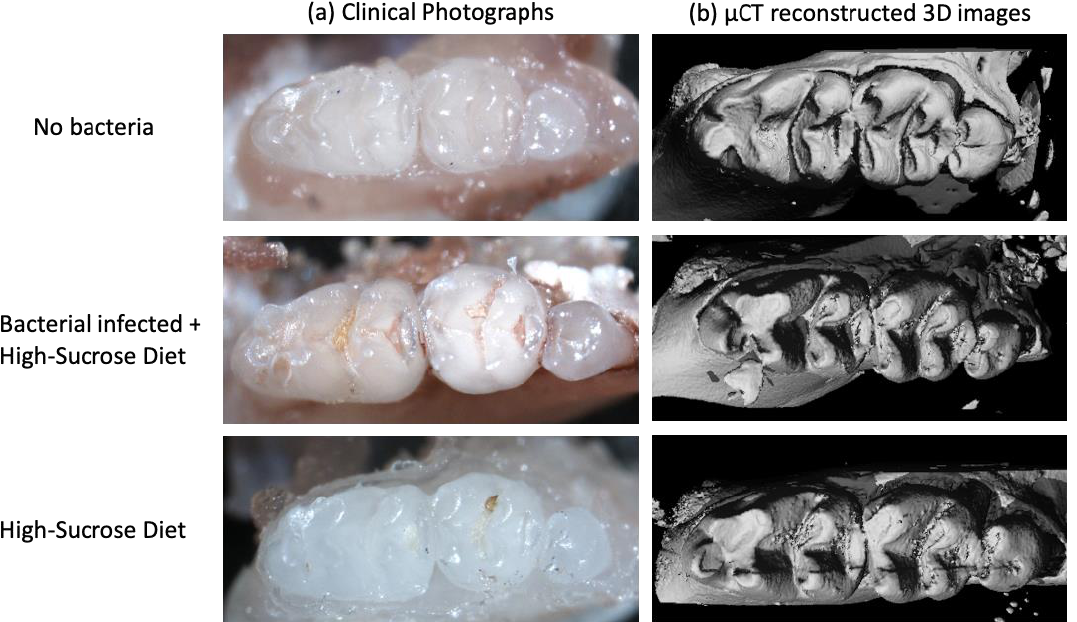
Figure 7. Clinical and radiographic evaluation demonstrates carious lesions development by S. mutans UA159 bacterial infection and high-sucrose diet. ( a ) Hemi-mandibles were photographed using stereomicroscope. Representative clinical photographs depict extensive carious lesions developed in the S. mutans UA159 bacterial infected + high-sucrose diet group, no carious lesions were depicted in the control and high-sucrose diet groups. ( b ) Hemi-mandibles were segmented and reconstructed to acquire 3D images by the µ